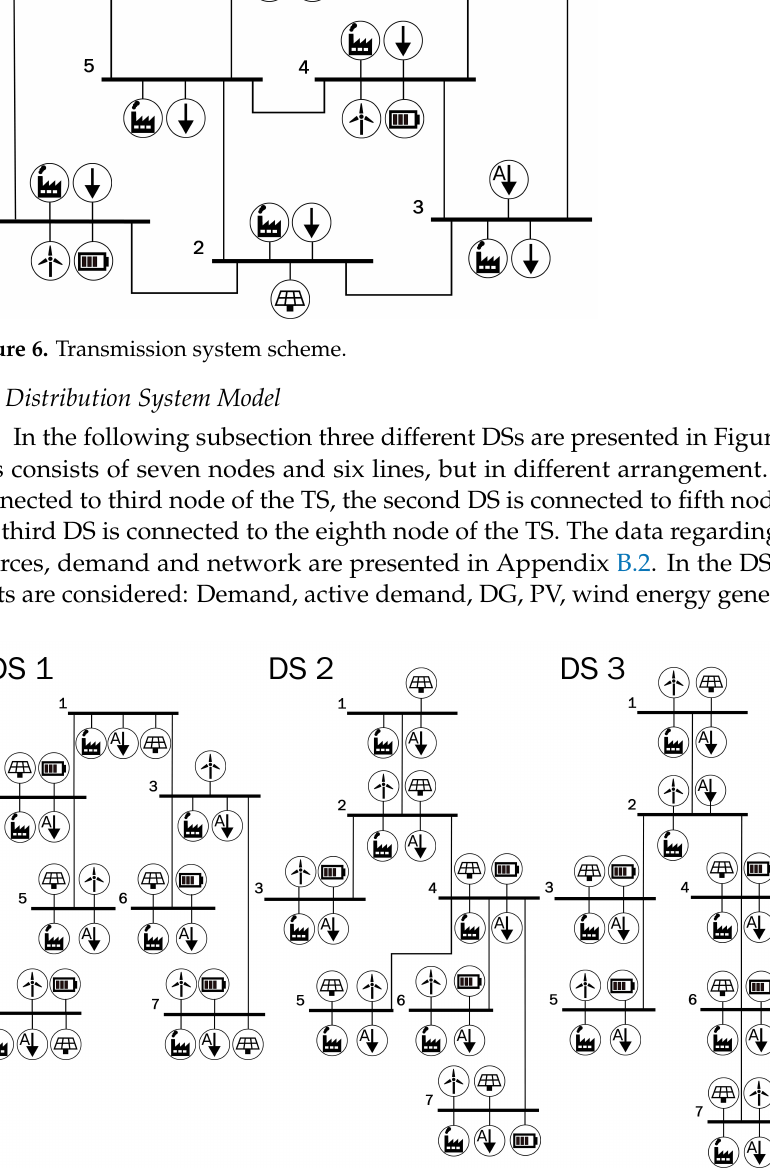
Figure 7. Distribution system